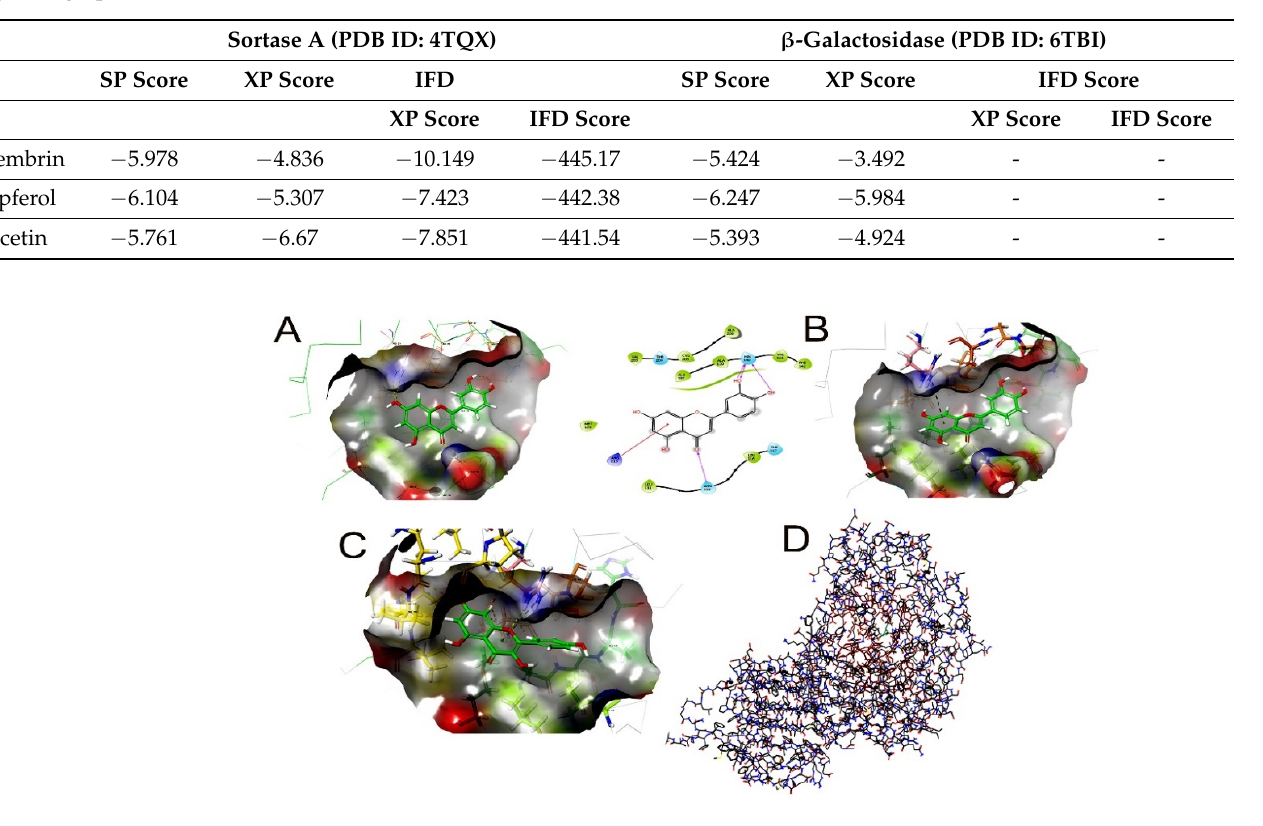
Figure 4. Molecular docking simulation on propolis compounds in Sortase A (4TQX) and -galactosidase (6TBI) ( A , B ) 4TQX SP3D HSA with propolis interaction with Sortase A. ( B ) Pinocem- brin has a binding energy of 10.14 and IFD score of − 445.17. The secondary structure is shown with their sub-domains identified. ( C ) The interaction of Kaempferol with neighboring residues in sub-domain 6TBI extracted from the docking results with values for HSA (black color) and b- galactosidase complex (red color) during 30 ns MD simulation ( D ) The interaction of Quercetin_ 6TBI